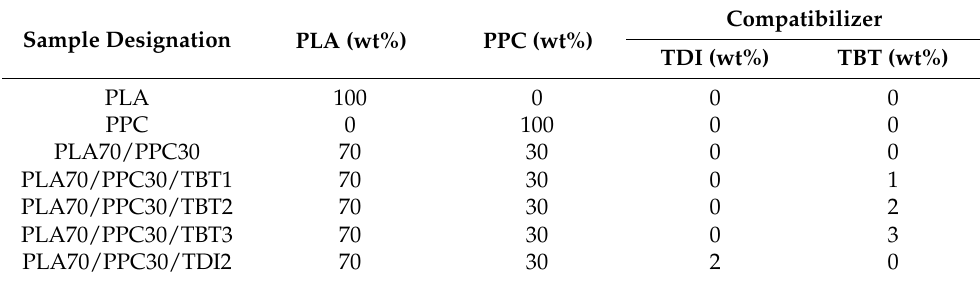
Table 1. The compositions of the PLA/PPC/TDI and PLA/PPC/TBT